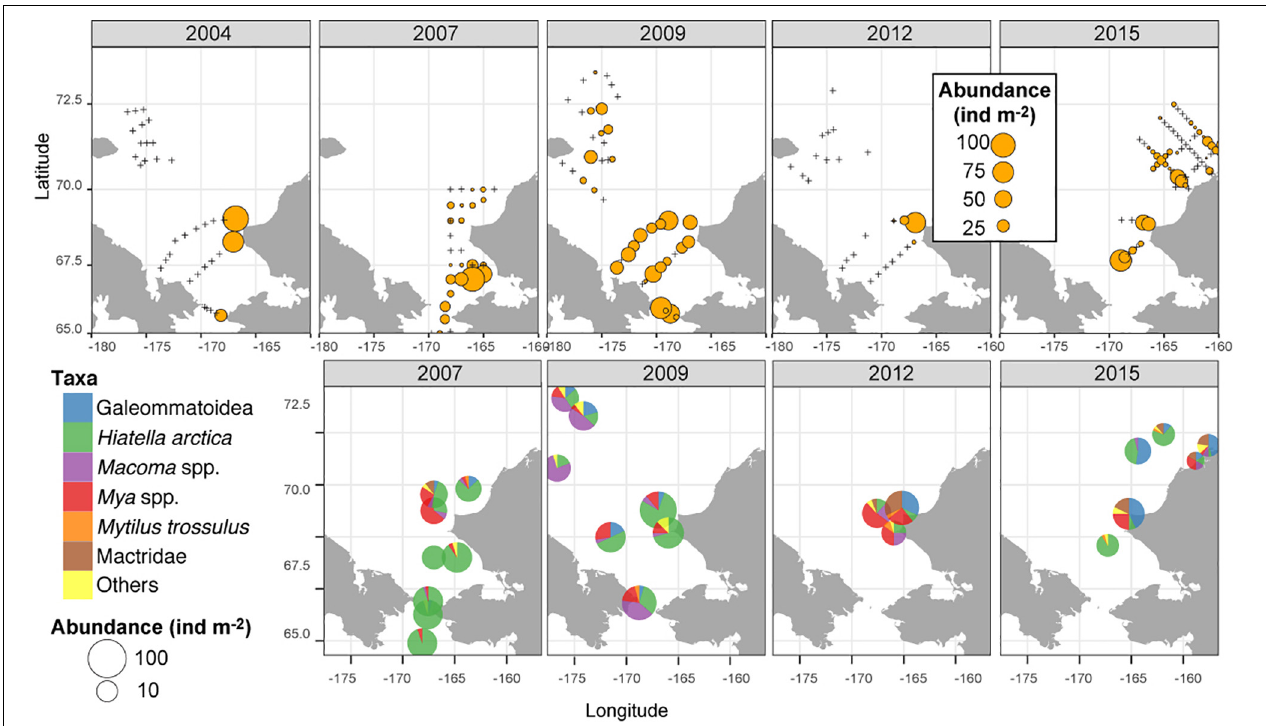
FIGURE 5 | Distribution of larval bivalves (top row, overall abundance; bottom row, relative contribution by different bivalve taxa in the meroplankton).